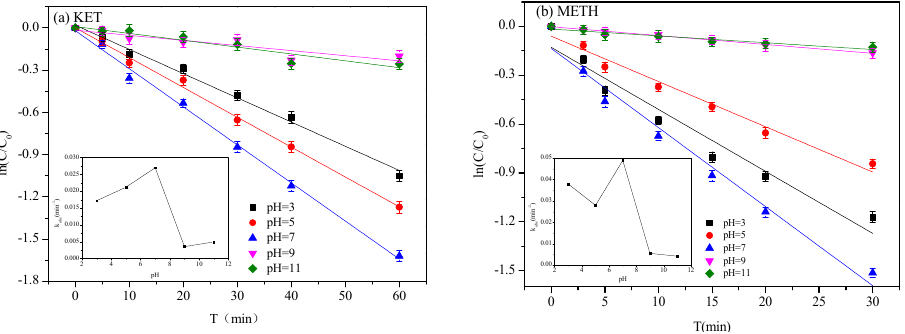
Figure 6. E ff ects of di ff erent initial pHs on the degradation of KET ( a ) and METH ( b ) in the UV / H 2 O 2 Figure 6. Effects of different initial pHs on the degradation of KET ( a ) and METH ( b ) in the UV/H 2 O 2 system. Conditions: (KET) 0 = (METH) 0 = 100 µ g / L, (H 2 O 2 ) 0 = 500 µ M, pH 0 = 3–11, T = 25 ± 1 ◦ system. Conditions: (KET) 0 = (METH) 0 = 100 μg/L, (H 2 O 2 ) 0 = 500 μM, pH 0 = 3–11, T = 25 ± 1 °C.